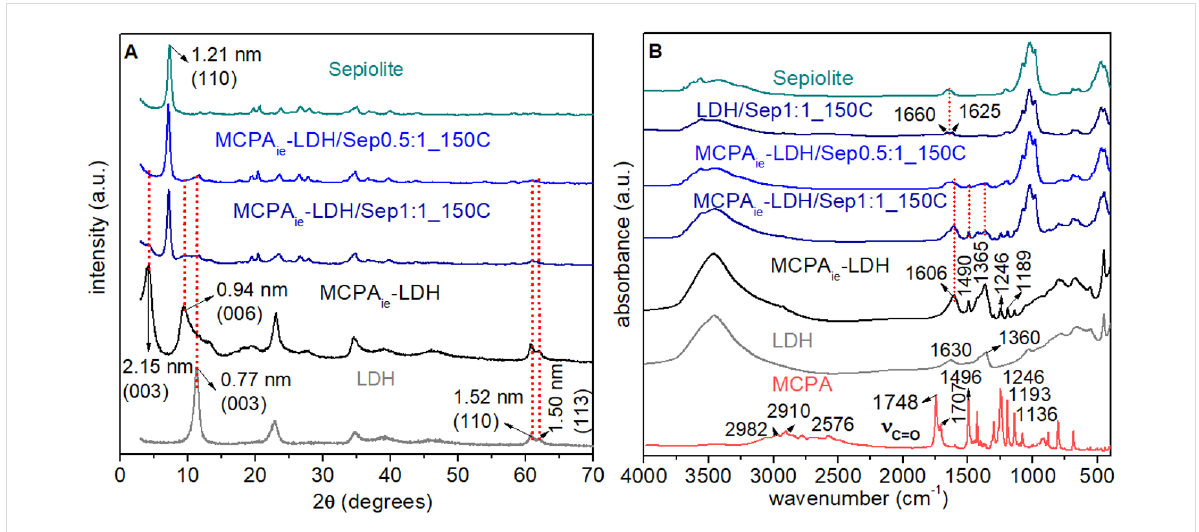
Figure 2: (A) XRD patterns and (B) FTIR spectra of individual components (sepiolite, LDH, and MCPA), MCPA ie -LDH intercalation compound and the neat LDH/Sep and MCPA ie -LDH/Sep hybrid nanoarchitectures.